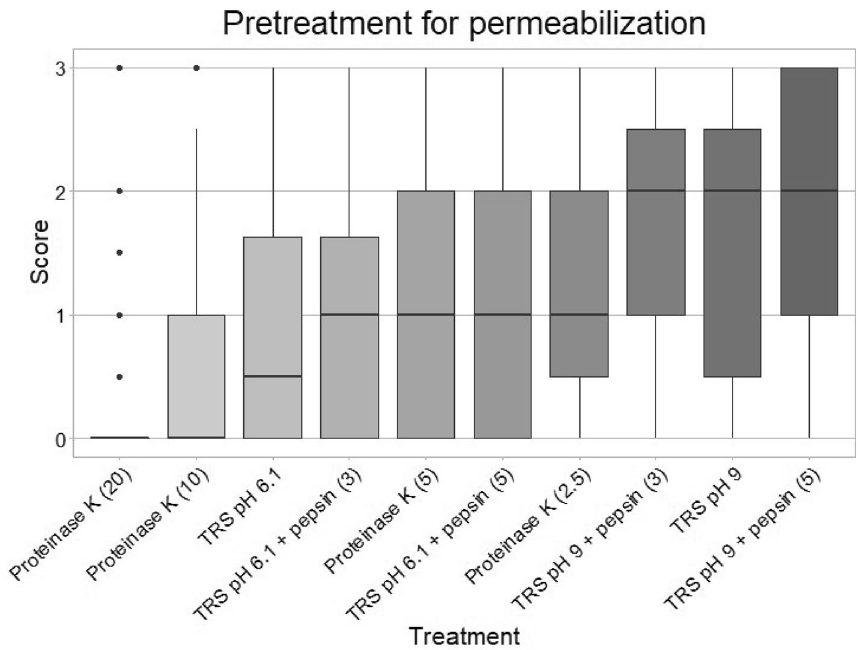
Figure 2. Boxplot of score distribution according to pretreatment of formalin-fixed paraffin-embedded tissues. Choice of pretreatment for permeabilization: Heat-induced microRNA Retrieval in Target Retrieval Solution (TRS) pH 6.1, TRS pH 9 or proteolysis with proteinase K. Exposure time for proteolysis treatment is given in minutes and presented in (). All scores are given regardless of tissue type, hence revealing the overall score of probe-staining effectivity. The x-axis shows type of treatment. The y-axis shows the mean score of the probe staining on a scale from 0 to 3, where 0 = no staining of the probe, and 3 is strong staining of the probe. The darker the color, the better the staining. The figure was constructed with the statistical software R.